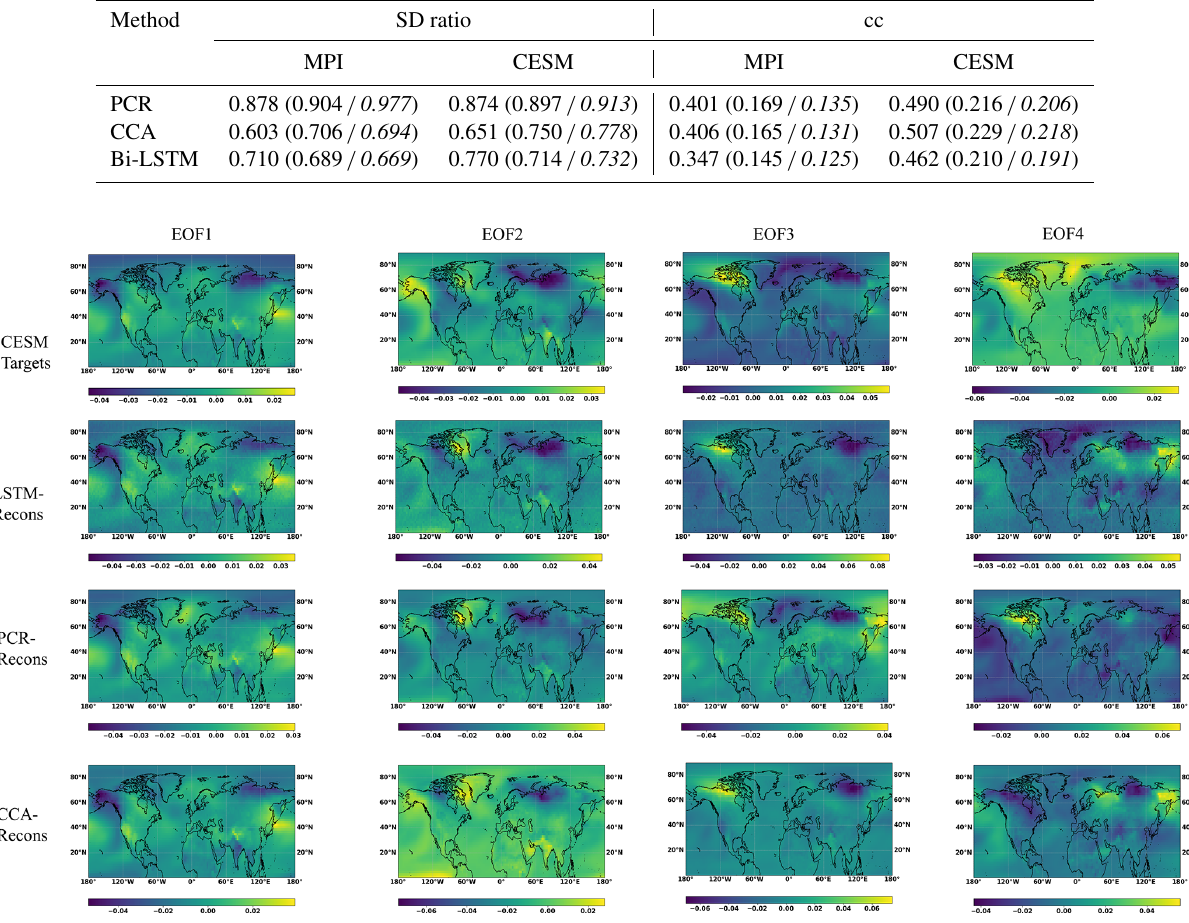
Figure 8. The first four EOF patterns of the temperature field derived from CESM target, and from the temperature field reconstructed by the three methods-based ideal